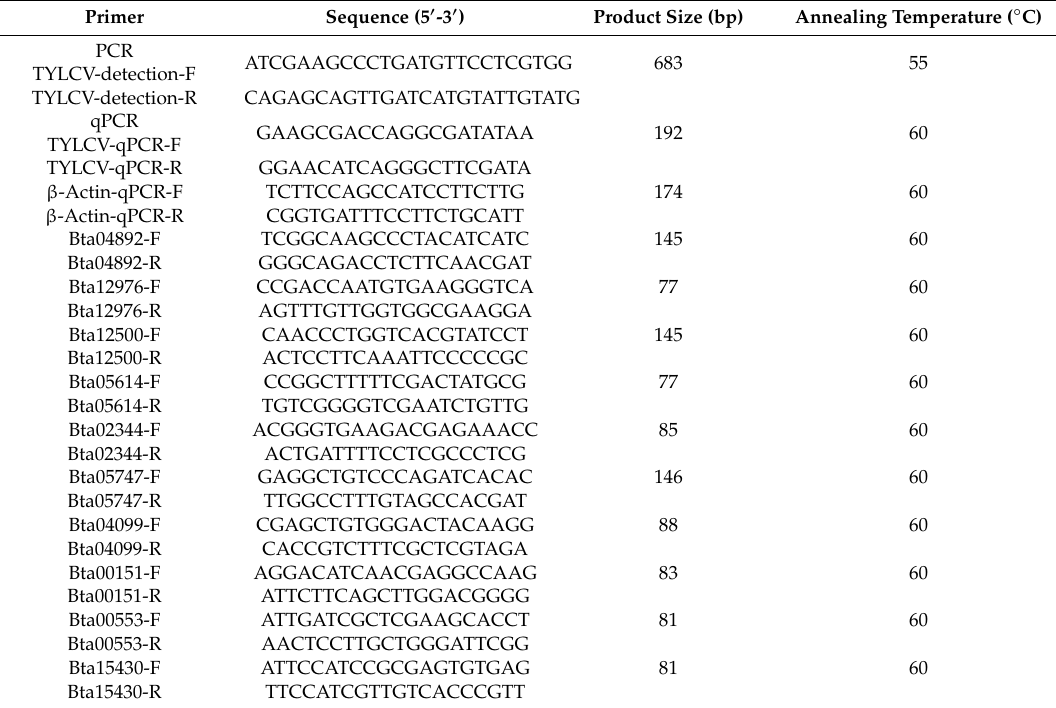
Table 1. Primers for PCR / qPCR